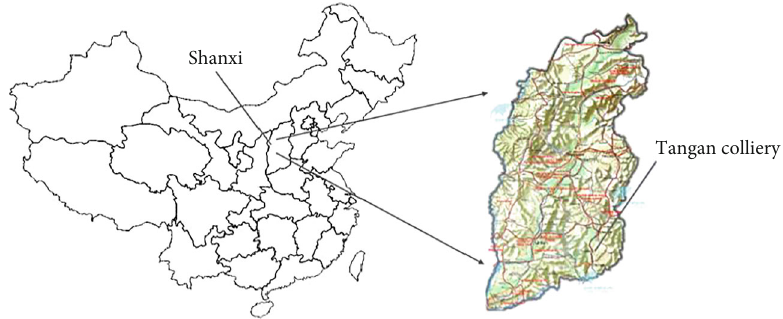
Figure 4: The location of Tangan colliery.